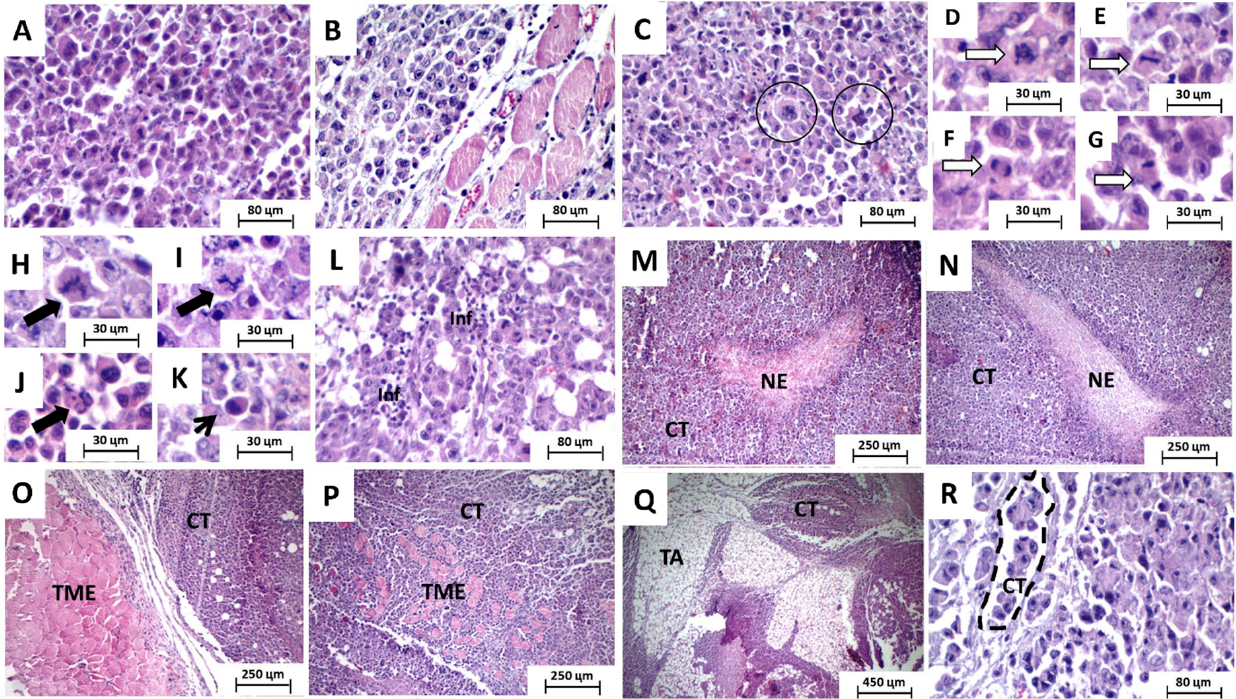
Figure 2. Photomicrographs of HE-stained histological sections of surgical specimens of sarcoma 180 implanted in rodents. Circles—giant tumor cells with bizarre nuclei; white arrows—typical mitotic figures; dark arrows—atypical figures; thin arrow—apoptotic bodies; dashed line—presence of tumor cell emboli within blood vessels A-C, Rx400, D-K x800, and M-Q x100. Caption: CT—viable tumor cells; NE—coagulative necrosis; TME—skeletal striated muscle tissue; TA—subcutaneous adipose tissue. ( A , B ) prominent nucleoli; ( C ) tumor giant cells with hyperchromatic misshapen nuclei; ( D ) prophase; ( E ) metaphase; ( F ) anaphase; ( G ) telophase; ( H ) atypical tripolar spindles; ( I ) atypical tetrapolar spindles; ( J ) atypical prophases; ( K ) apoptotic bodies; ( M , N ) comedo-type necrosis; ( L ) peri and intratumoral inflammatory infiltrate rich in lymphocytes; ( O ) tumor cells compressing the peripheral skeletal muscle tissue; ( P ) tumor cells invading and dissociating skeletal muscle tissue; ( Q ) tumor cells permeating and disorganizing the subcutaneous adipose tissue; ( R ) tumor cell emboli within blood vessels.